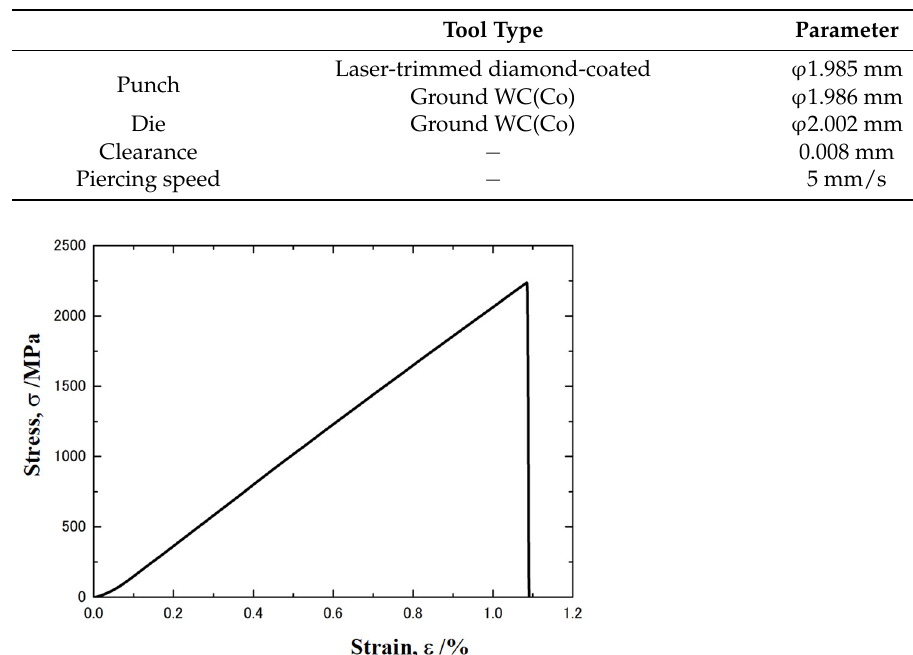
Table 2. Size and dimension of punch and die with the piecing condition.